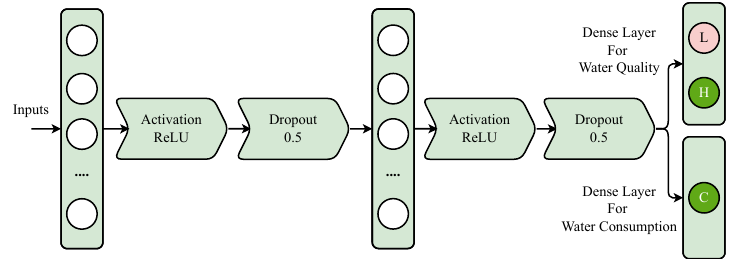
Figure 4. Architecture of proposed ANN